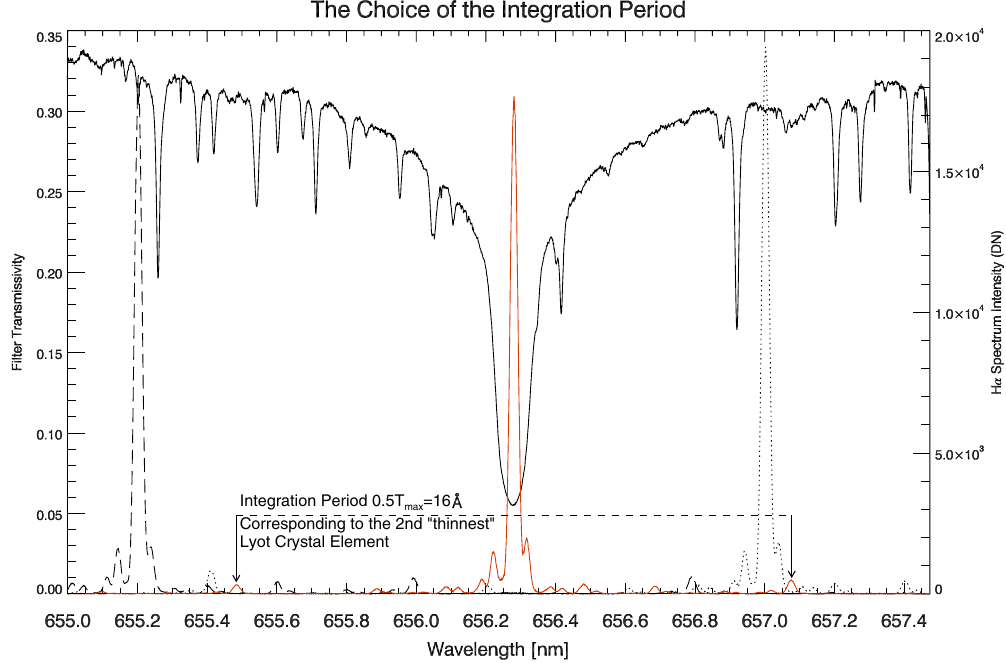
Figure 5. The integration range. According to our definition, the integration period should be 32 Å which is out of the range of camera. We have to use two types of integration: one is fixed period marked by the two solid arrows corresponding to the 2nd element period; the other is variable integration range. The BF peak transmittance is about 30 % as the same as Fig. 6 in Hagino et al. (2014). The instrument materials absorbtion 2 problem can be attributed to the coefficient A in the third formula of equation array